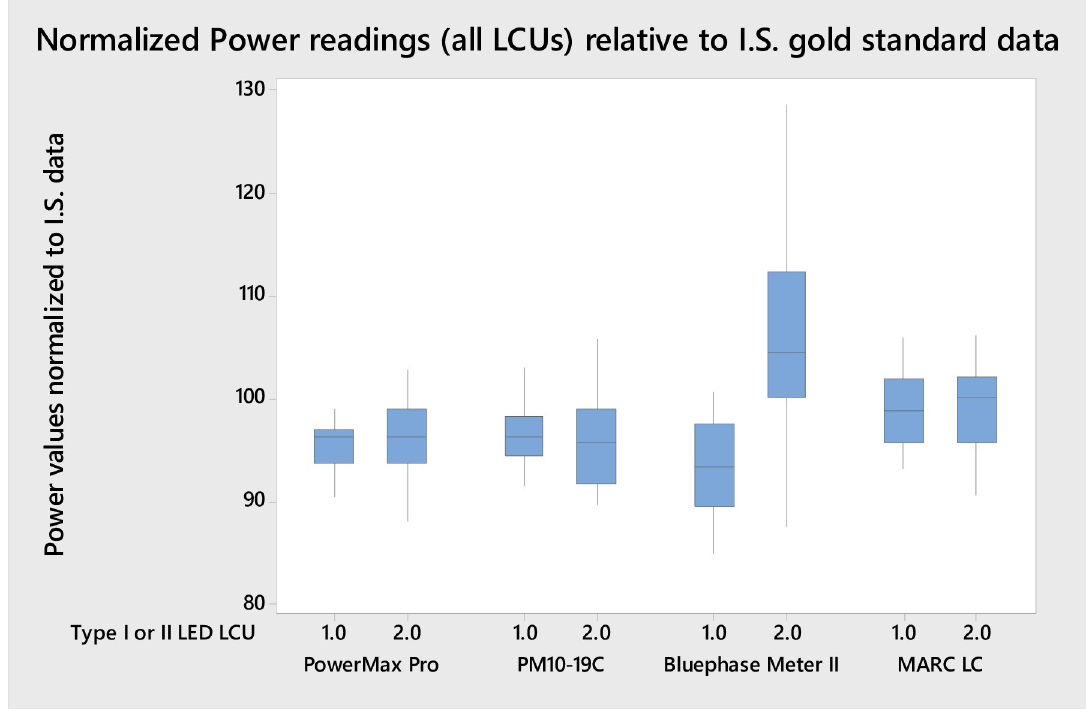
Fig 2. Pooled normalized mean power readings for all LED-LCUs relative to the integrating sphere gold standard data 100% values. Note the difference between the Type I and Type II LED-LCU data distributions for the BM II units (average of the three tested units shown) compared with the two laboratory-grade power meter instruments and the MARC LC integrating sphere / spectrometer